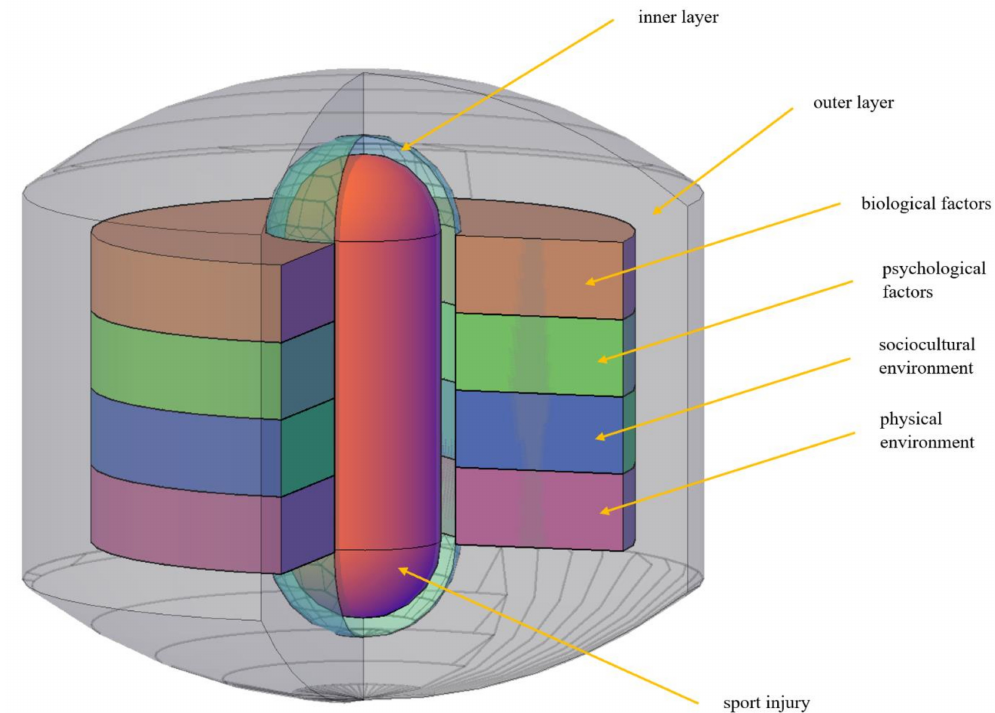
Figure 1. Sport injury antecedents and consequences visualization